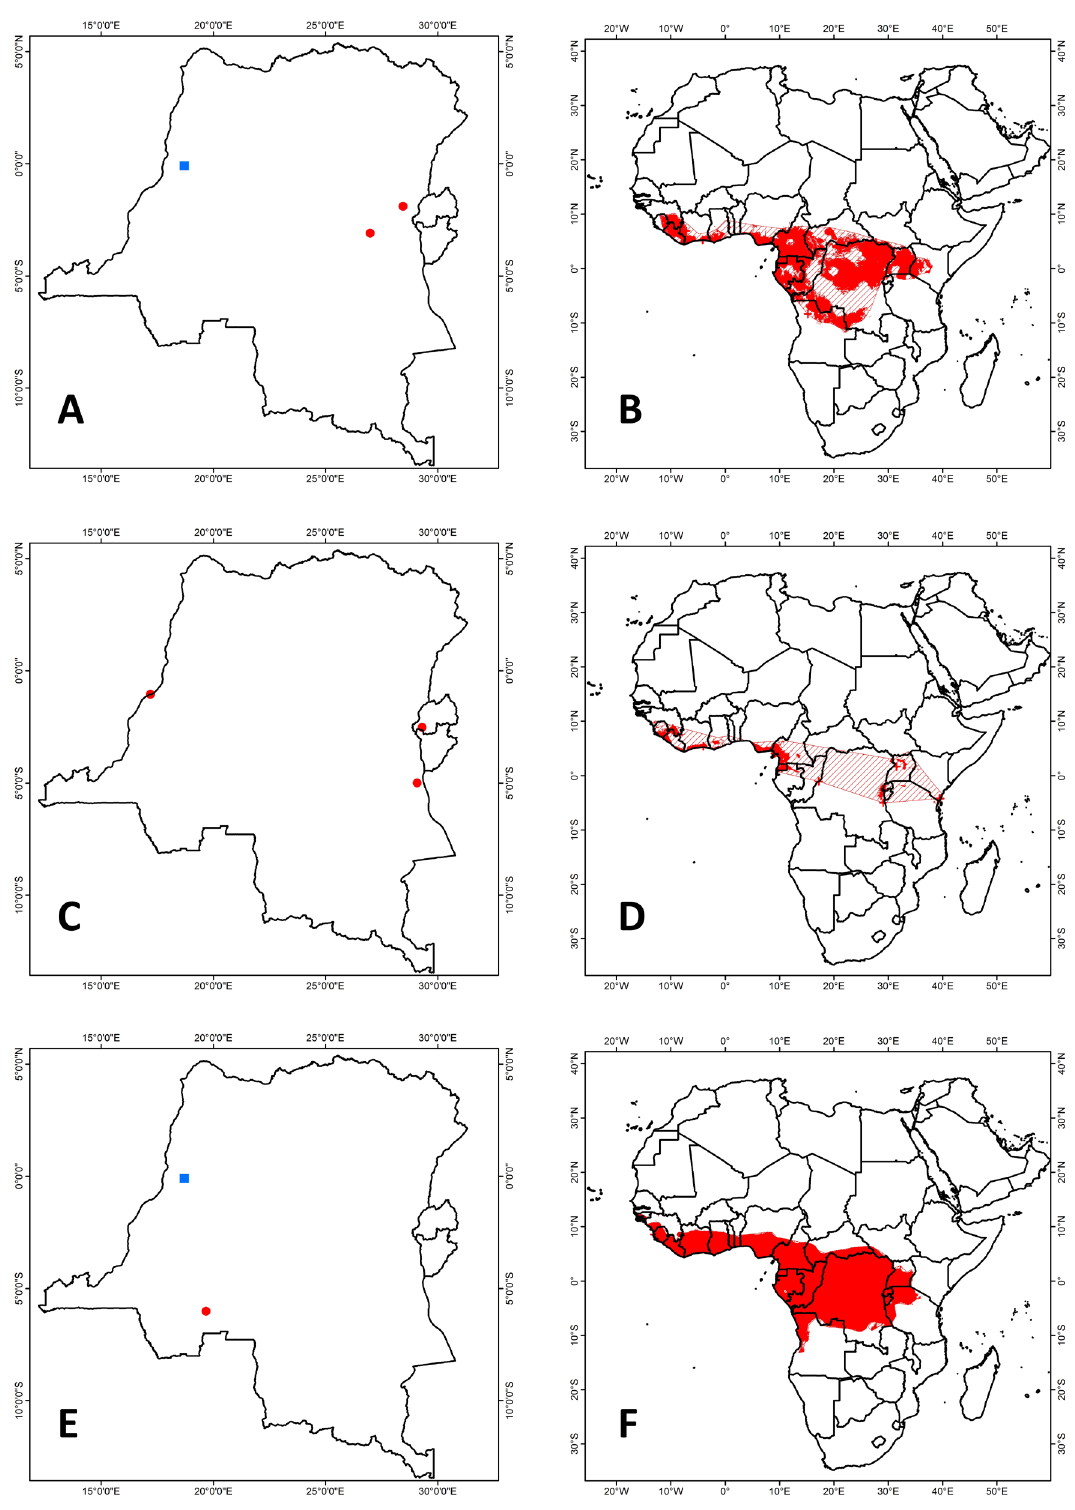
Fig. 41. Distribution maps. A–B . Hypsugo crassulus (Thomas, 1904). C–D . Hypsugo cf. eisentrauti (Hill, 1968). E–F . Hypsugo musciculus (Thomas, 1913). A, C, E. Distribution in the CRB area. B, D,